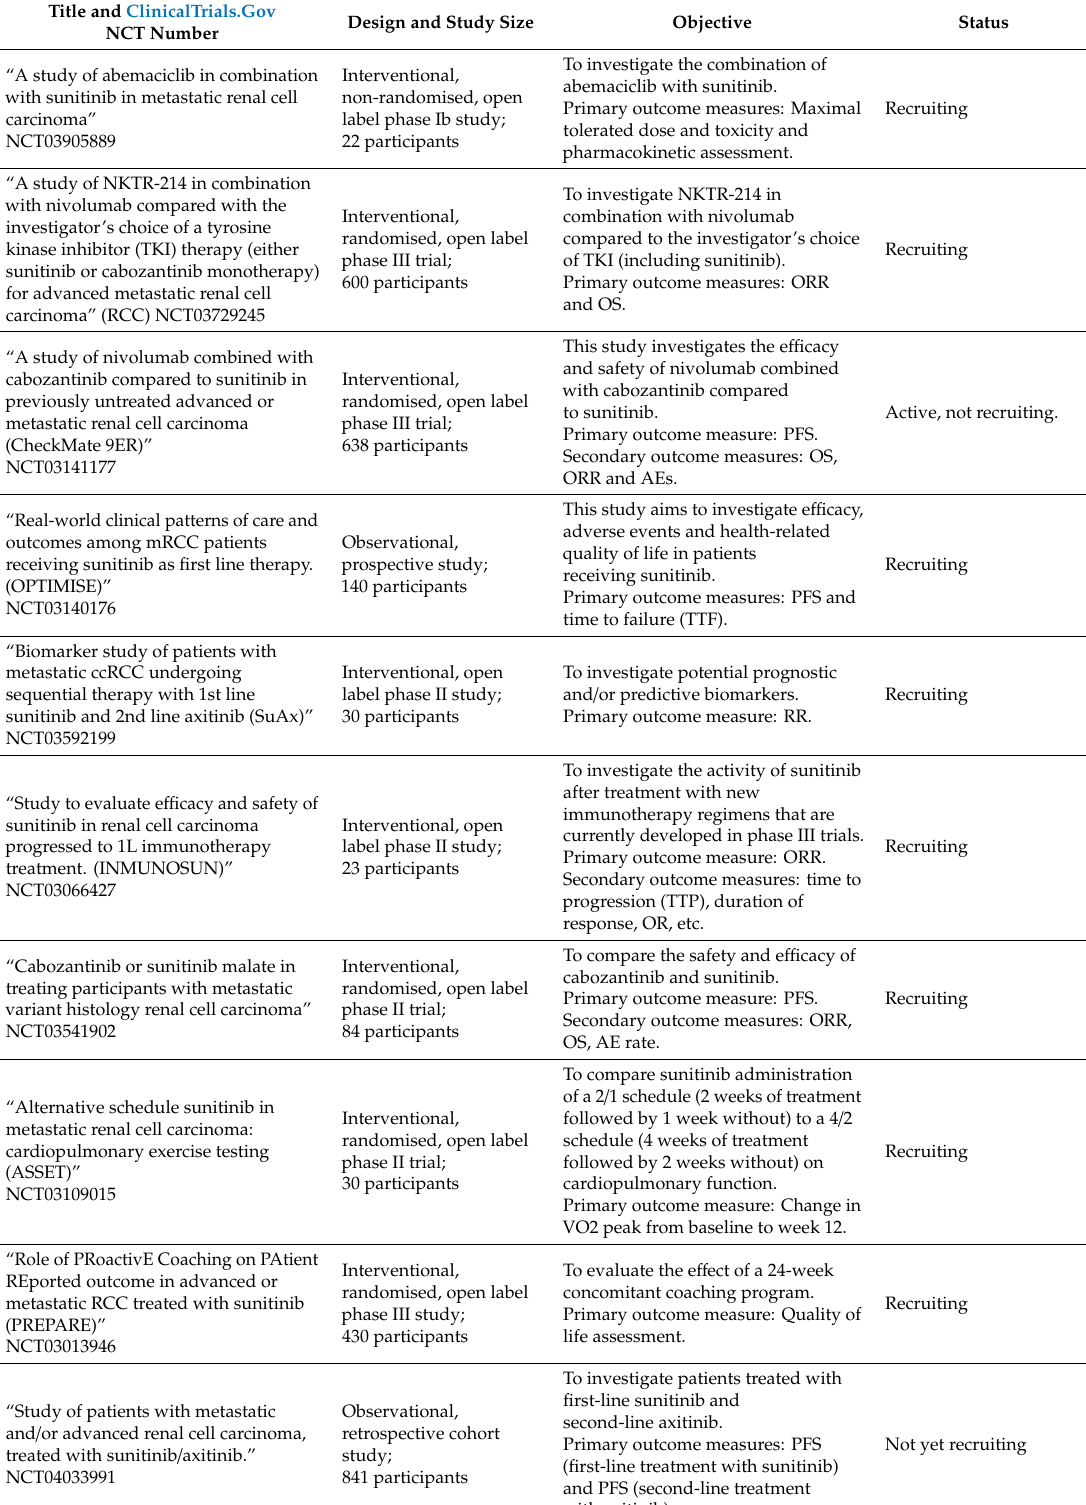
Table 6. Currently active clinical trials on the use of sunitinib for renal cell carcinoma therapy